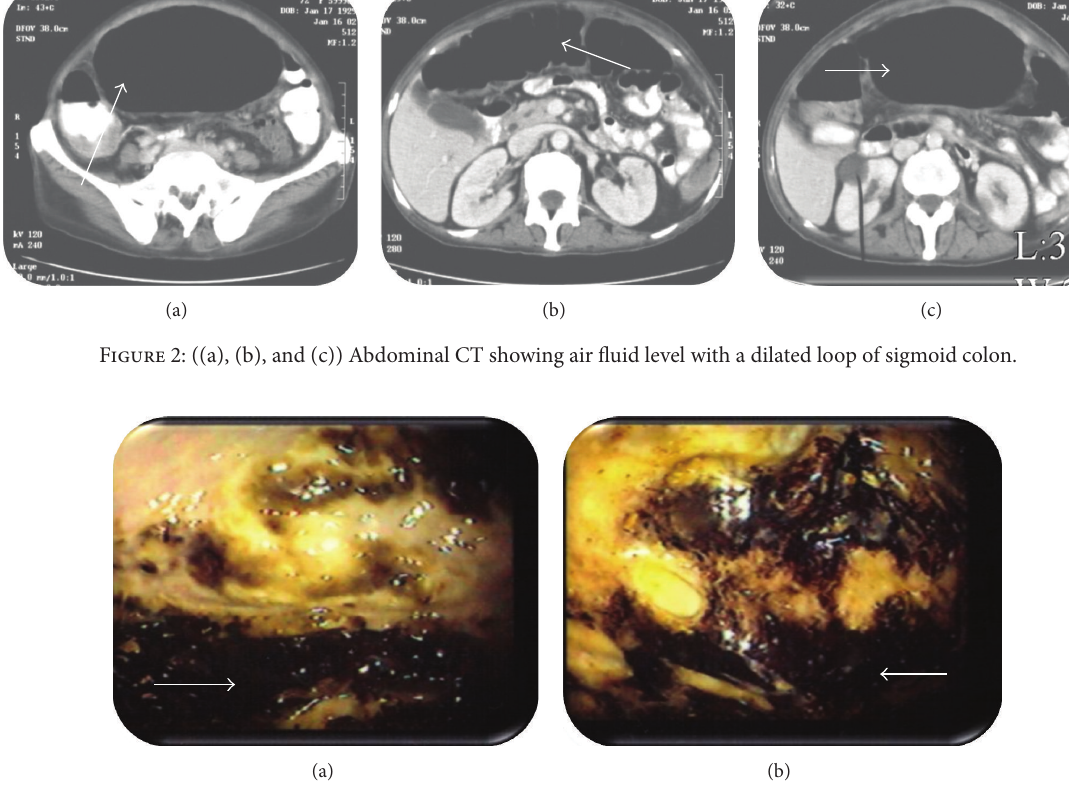
Figure 3: ((a), (b)) Colonoscopy showing a large filled cavity lined by blackish appearing serosa